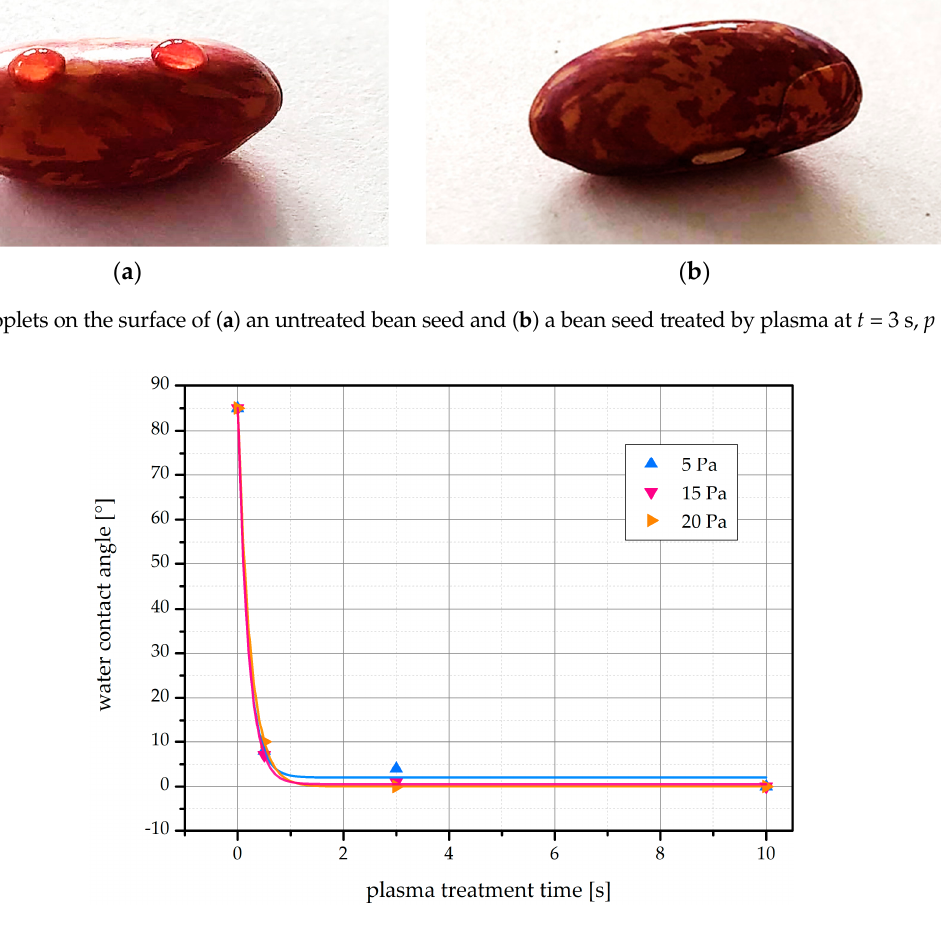
Figure 3. WCA on the surface of bean seeds immediately plasma treatment. Recorded after different plasma treatment times (0–10 s) using different gas pressures (5–20 Pa). Exponential curves were fitted to the data.